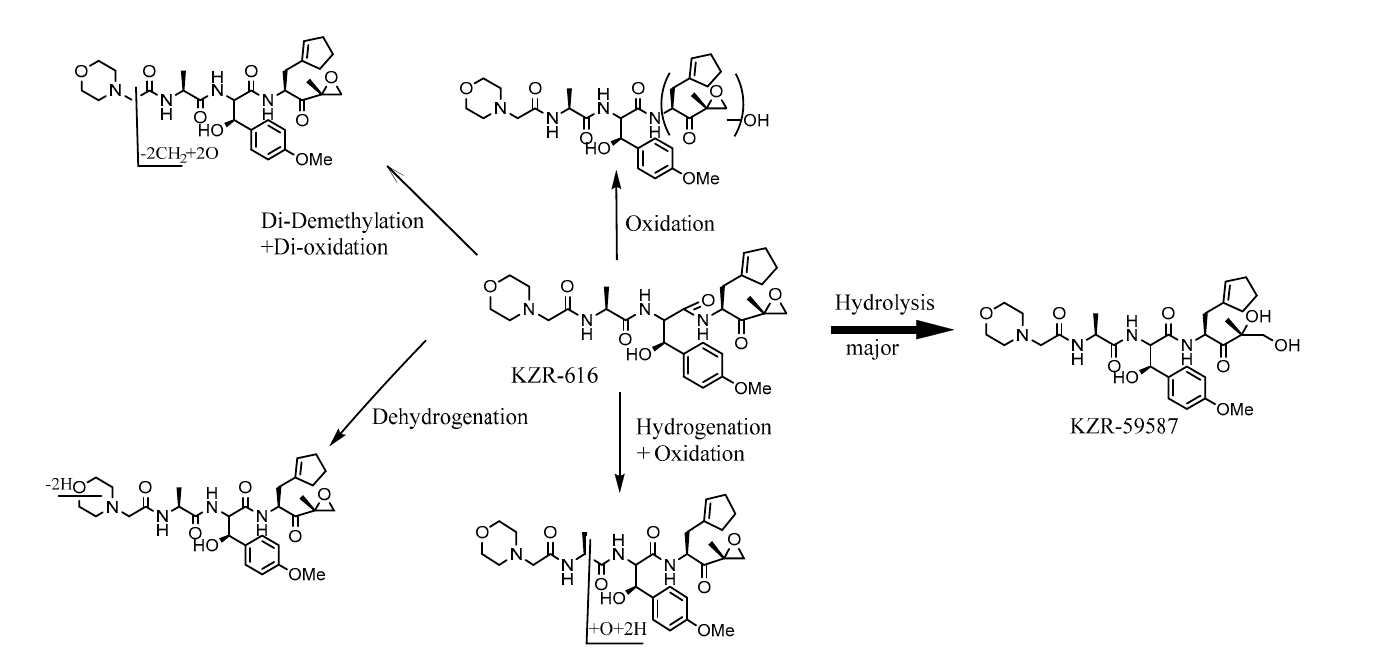
Scheme 5. Metabolic pathway of KZR-616 by